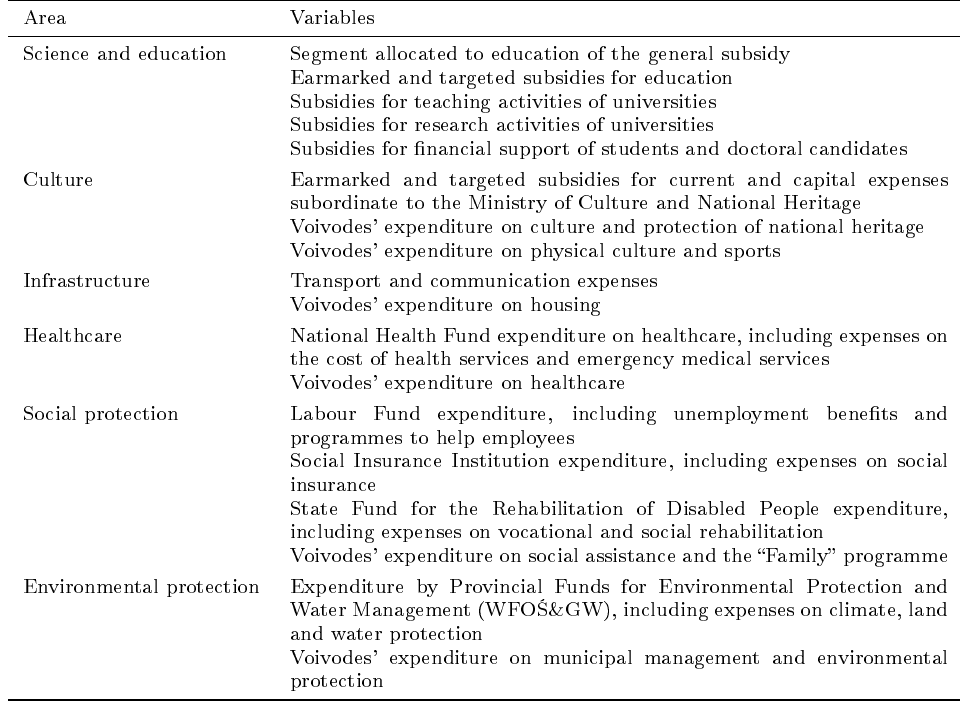
Table 1: List of government expenditures included in the